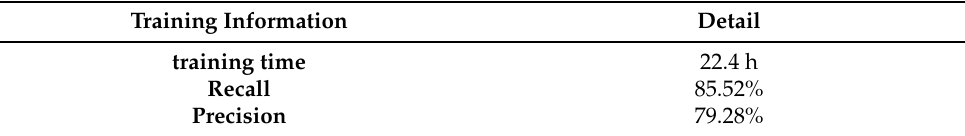
Table 5. Training information of Buiding-Aware